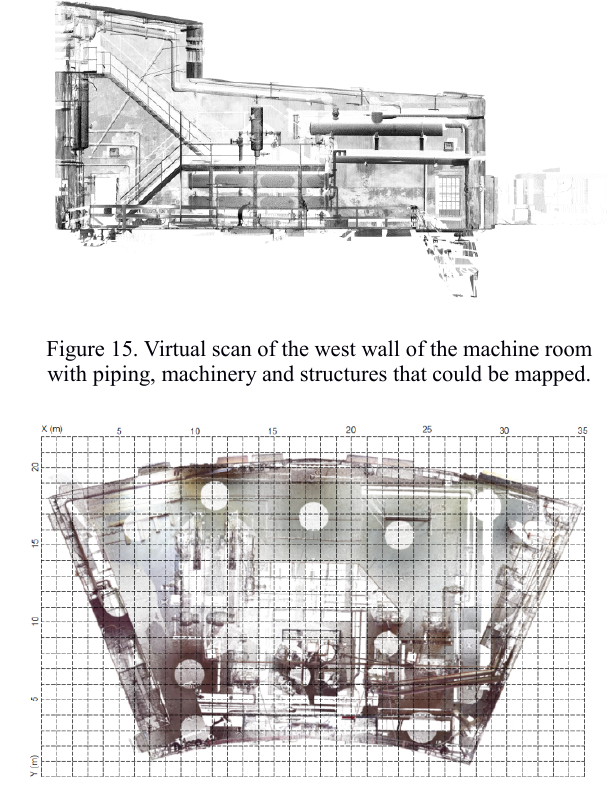
Figure 16. Virtual scan that represents the plan of machine room with a grid as scale